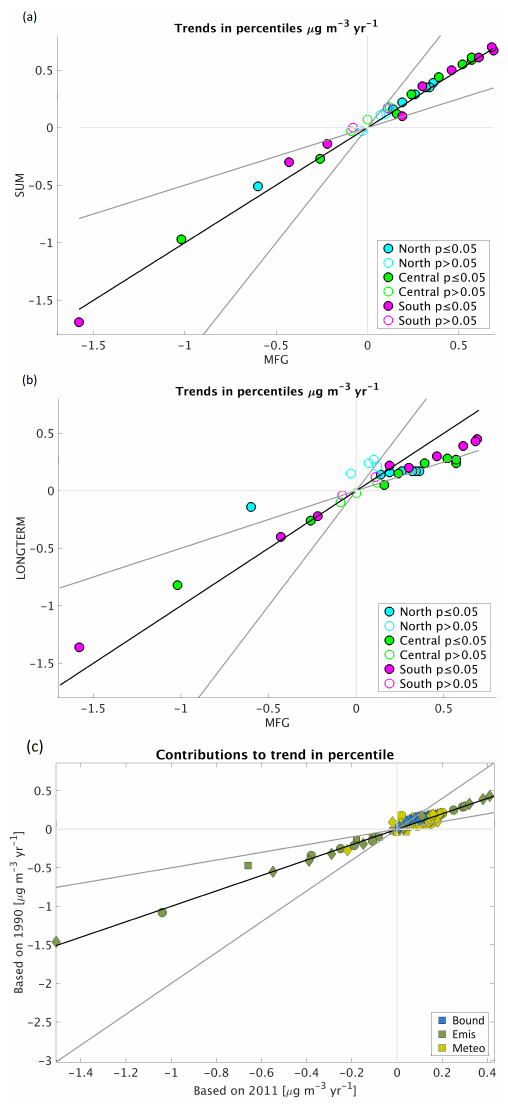
Figure 5. (a, b) Temporal trends in annual percentiles of hourly mean near-surface ozone (levels: 0, 2, 5, 10, 25, 50, 75, 90, 95, 98 and 100; see Table S2) averaged for the three regions: north (blue), central (green) and south (magenta) for the sum of the contribu- tions to the trend (SUM) vs. the MATCH model simulation MFG (a) and the reanalysis LONGTERM vs. the MATCH model simulation MFG (b) . Filled circles indicate significant trends ( p ≤ 0 . 05) in the MFG simulation, whereas non-significant MFG trends ( p> 0 . 05) are indicated by an empty circle. (c) Sensitivity in contributions to the secular trends in regionally (north: squares; central: circles; south: diamonds) averaged annual percentiles (levels: 0, 2, 5, 10, 25, 50, 75, 90, 95, 98 and 100) of hourly near-surface O 3 over the period 1990–2013 due to choice of base year (1990 vs. 2011). Mod- eled contributions to the near-surface ozone trend due to change in top and lateral boundaries of relevant species (dark yellow, bound), change in full domain emissions (blue, SE emis + FD emis) and variation in meteorology (light yellow, meteo). 1 : 1 line in black, factor 2 lines in dark